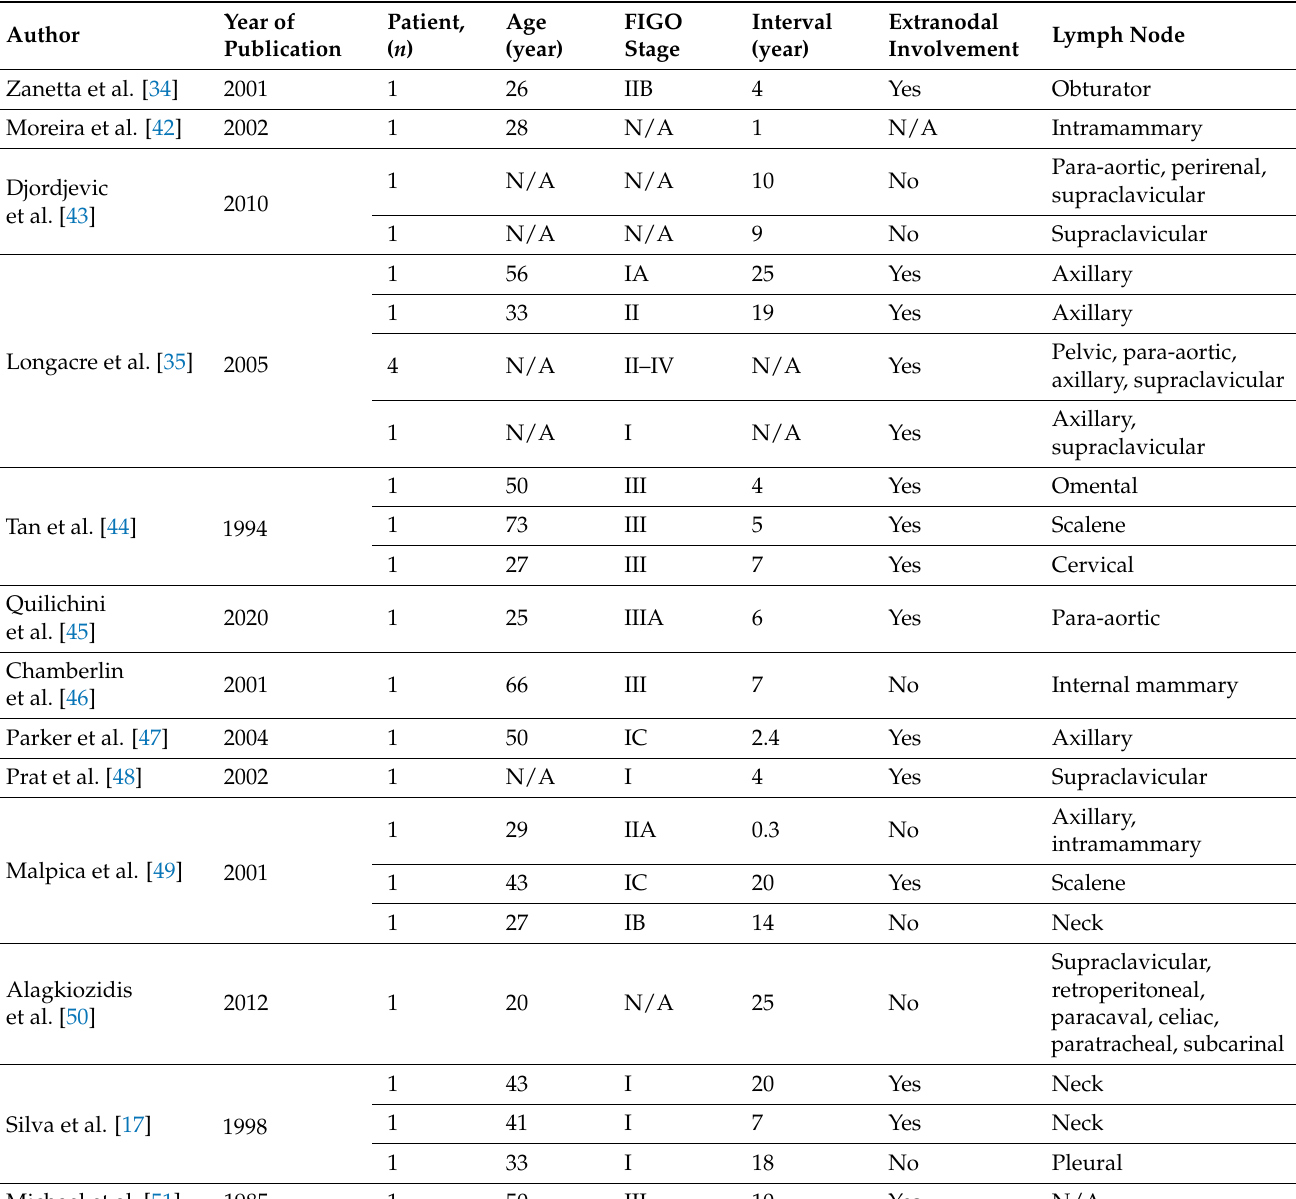
Table 1. Clinical characteristics of cases of SBOT with lymph node involvement at recurrence.